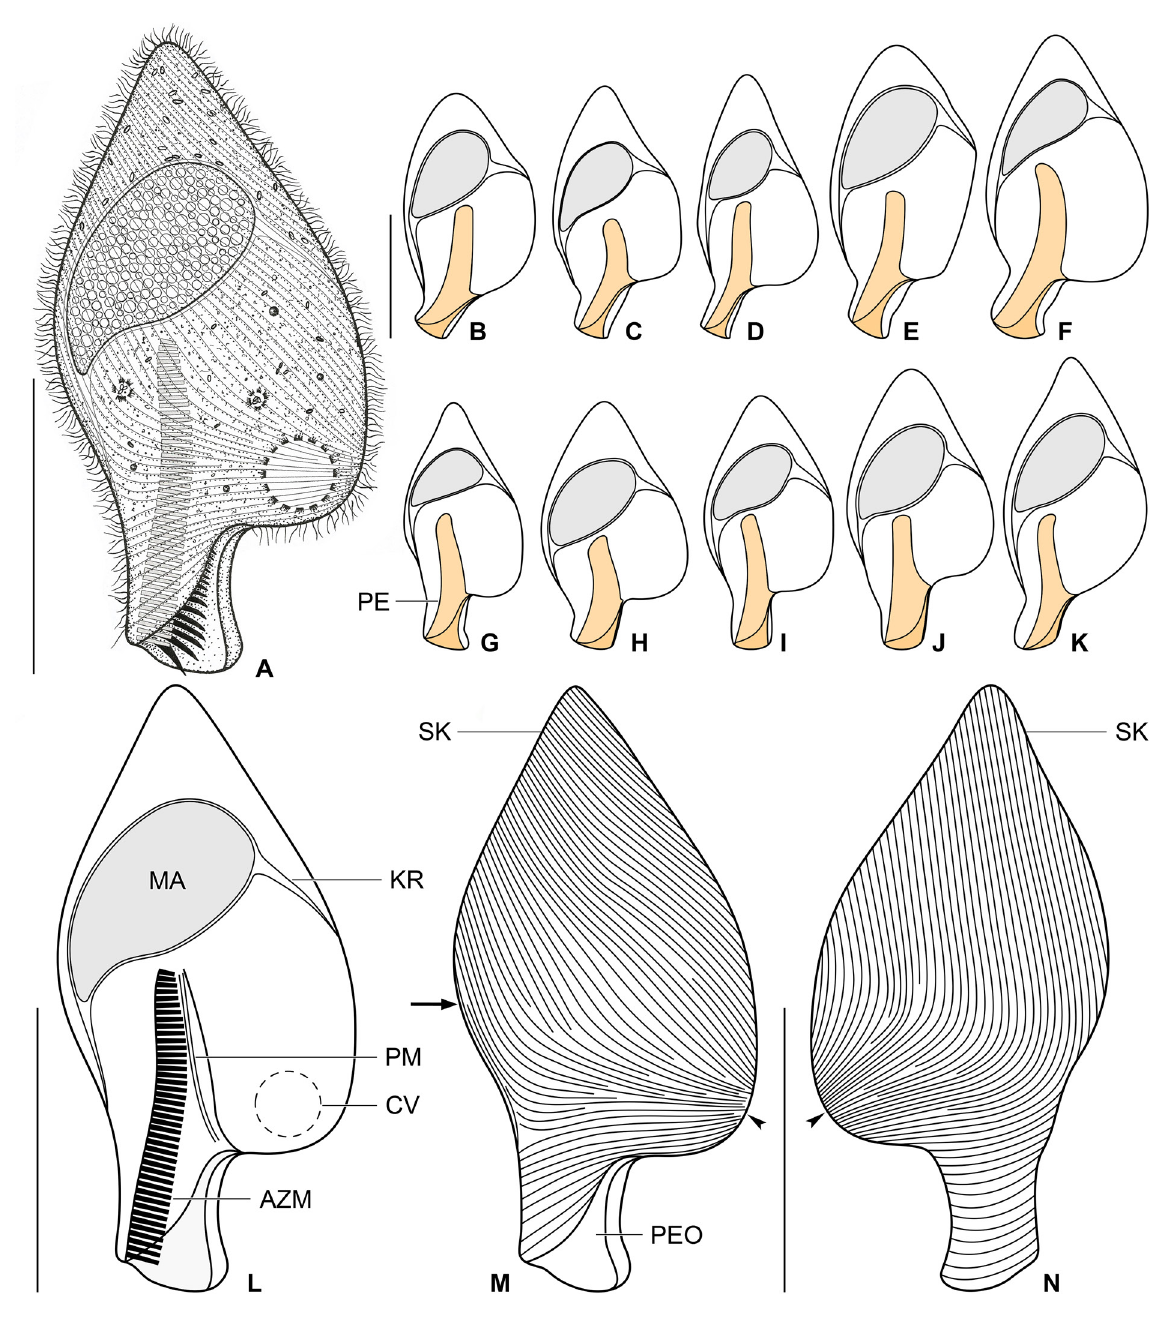
Fig. 6. Clevelandella panesthiae (Kidder, 1937). Thai I specimens isolated from Panesthia angustipennis angustipennis (Illiger, 1801) from life (A) and after protargol impregnation (B–N). A . Ventral view of a representative specimen, length 105 μm. B–K . Variability of body shape and size as well as of the nuclear (shaded grey) and oral (shaded yellow) apparatus. L . Semi-schematic diagram, showing the general body organization. M–N . Ciliary pattern of ventral and dorsal sides. Arrow marks the right suture, black arrowheads denote the position of the ciliary whorl (posterior suture). Scale bars = 50